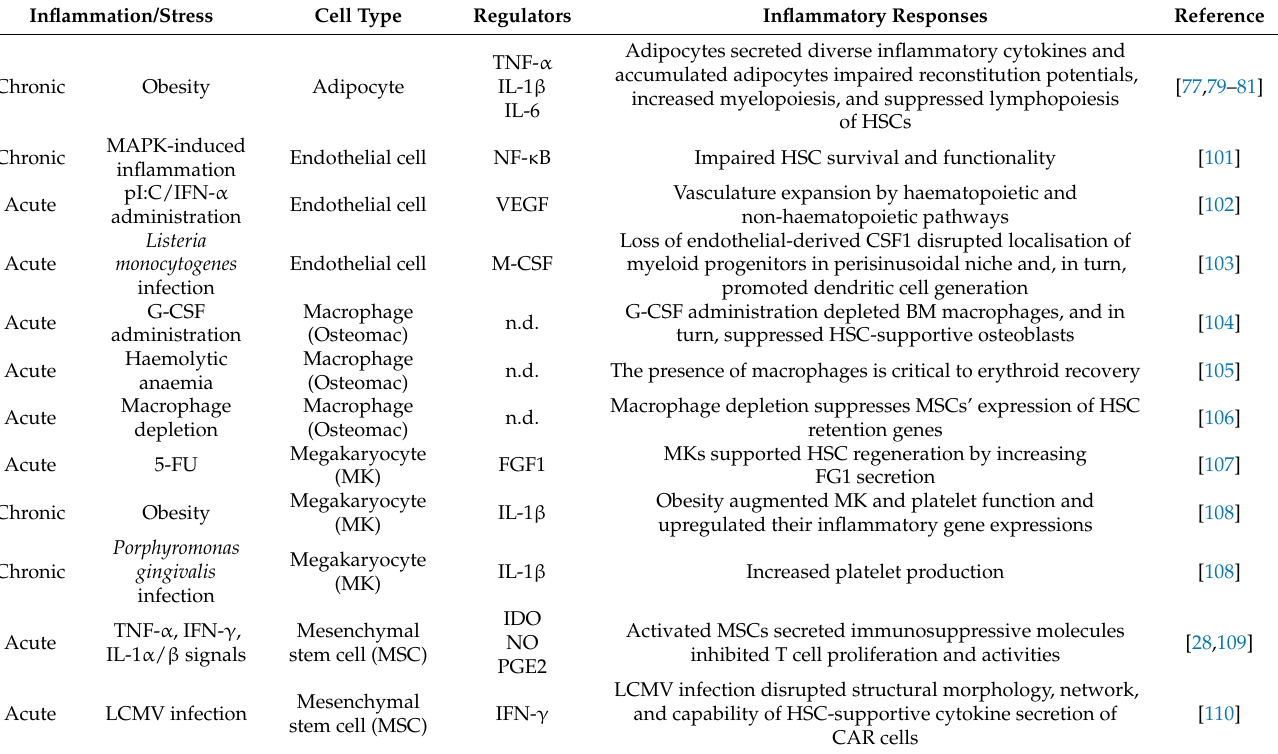
Figure 2. Pathogenic BM remodelling increases inflammatory stress on HSCs. In homeostasis, primitive HSCs prefer to reside in close proximity to sinusoids (sinusoidal niche) where the HSCs are supported by the HSC maintenance factors, such as CXCL12 and VCAM-1, secreted by various HSC niche cells. Inflammation suppresses the functions of HSC niche cells to produce the HSC maintenance factors, making the microenvironment unstable to support the HSC quiescence and contributing to HSC mobilisation. The HSC niche cells also participate in the secretion of inflammatory cytokines and impair the self-renewal potential of HSCs. The enriched pro-inflammatory cytokines and growth factors finally damage the primitive HSCs by promoting their cell cycling and apoptosis. Table 1. SummaryofinflammatoryresponsesofHSCnichecellsunderdifferentinflammatory/stress